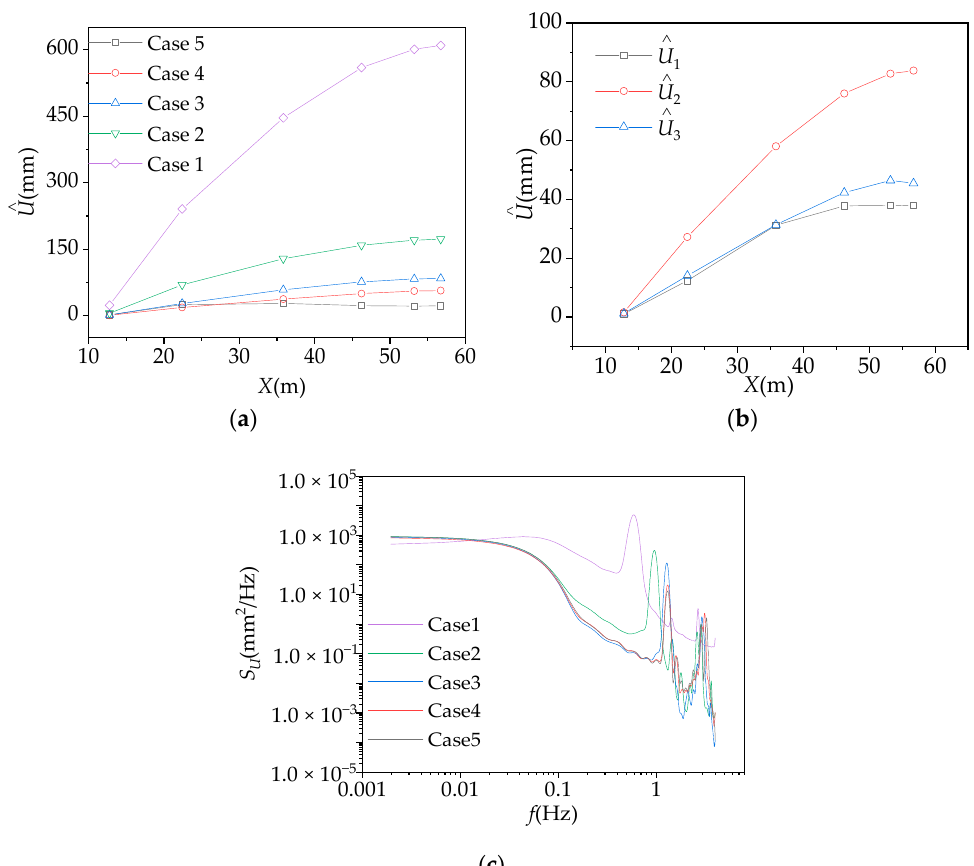
Figure 5. Wind-induced along-wind displacement analysis of the CBUSB with curvature transform: ( a ) peak displacement; ( b ) peak displacement of Case 3; and ( c ) bridge displacement response spectrum.